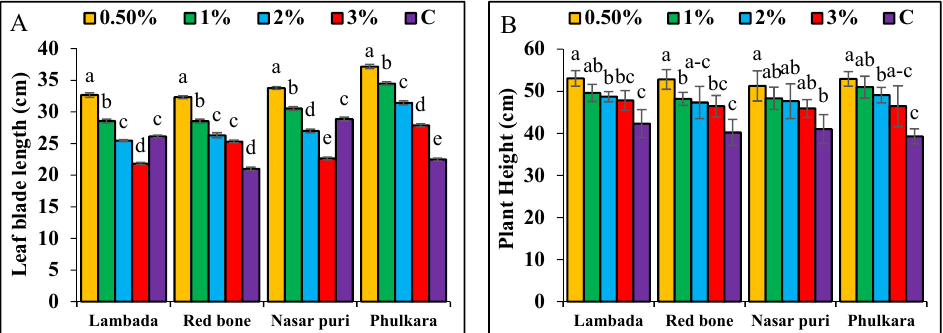
Figure 1. Leaf-blade length ( A ) and plant height ( B ) of onion cultivars as affected by foliar application of 0 (C = control), 0.5, 1, 2, or 3% seaweed extract. Values are means of nine replicates ± standard error. Means with different letters are significantly different from each other compared by least significant difference (LSD) at p ≤ 0.05.